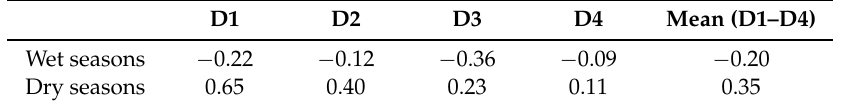
Table 5. Trend of average WLs in defined wet (dry) seasons at downstream locations. Unit: ( m·year − 1 ).